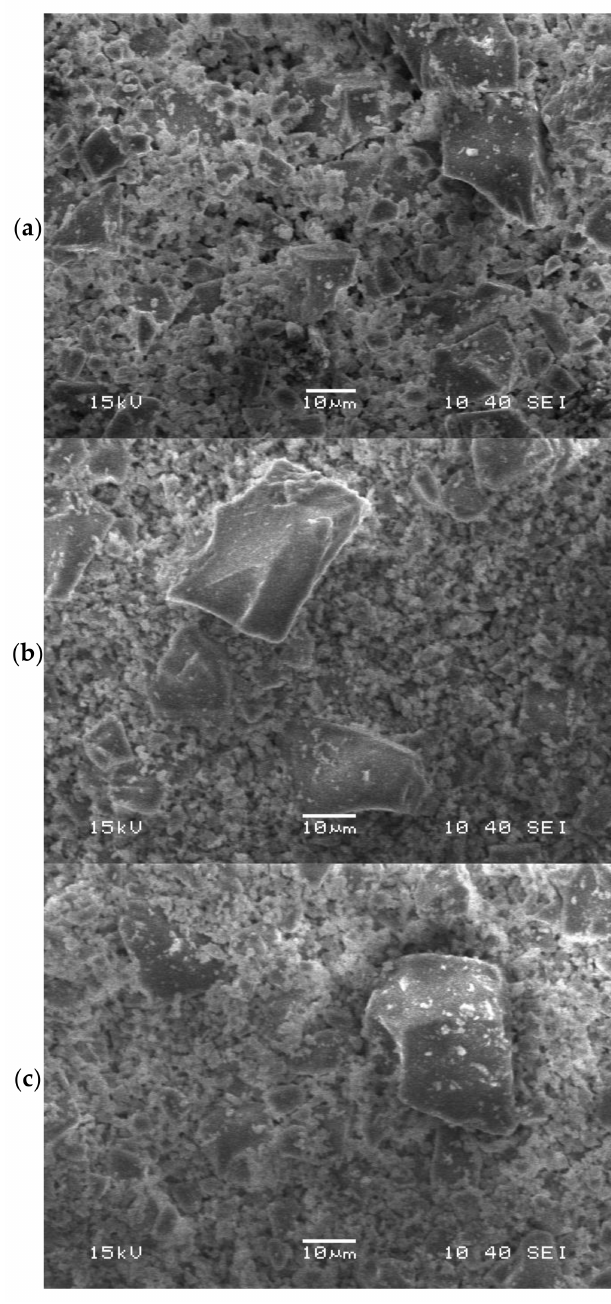
Figure 3. SEM image of ( a ) Fuji IX glass; ( b ) Kavitan Plus glass; ( c ) Chemadent G-J-W glass. Data on particle sizes of ionomer glasses are also shown in Table 2 and Figure